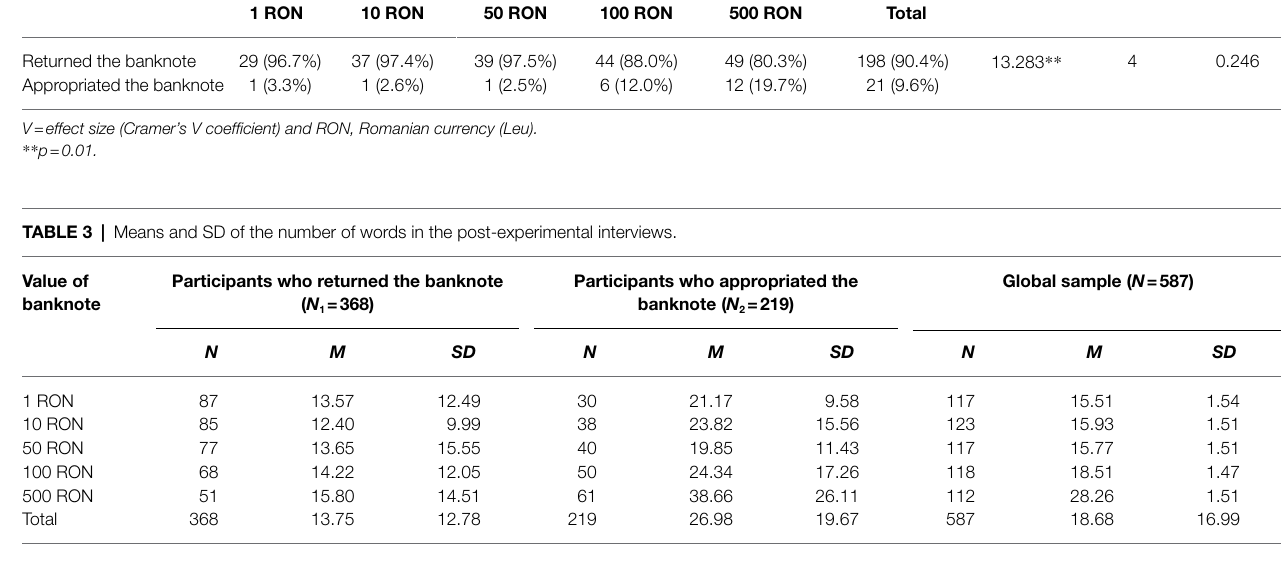
TABLE 2 | Cross-tabulation of values of the “lost” banknote and pro-social behavior toward the second confederate ( N = 219). Pro-social behavior (DV2)